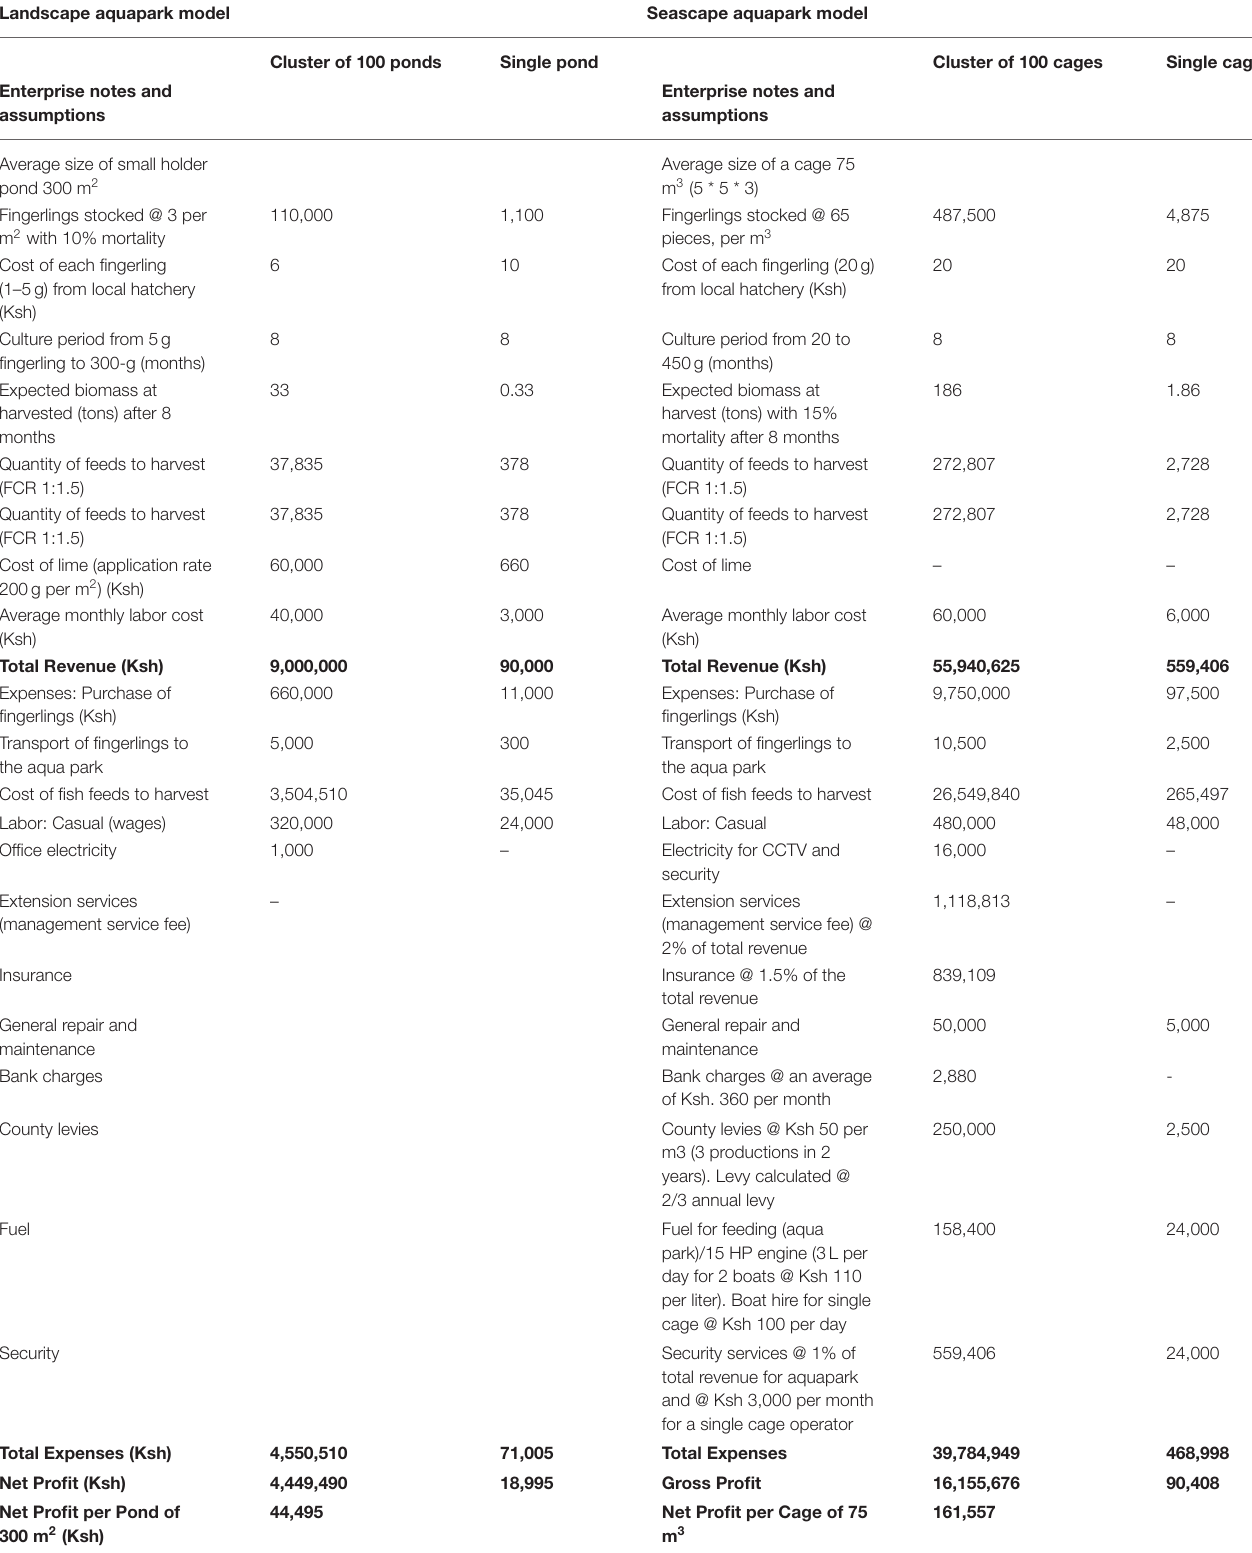
TABLE 1 | Business enterprise budget comparing fragmented and aggregated fish farming systems in landscape and seascape aquapark model in Busia county. Landscape aquapark